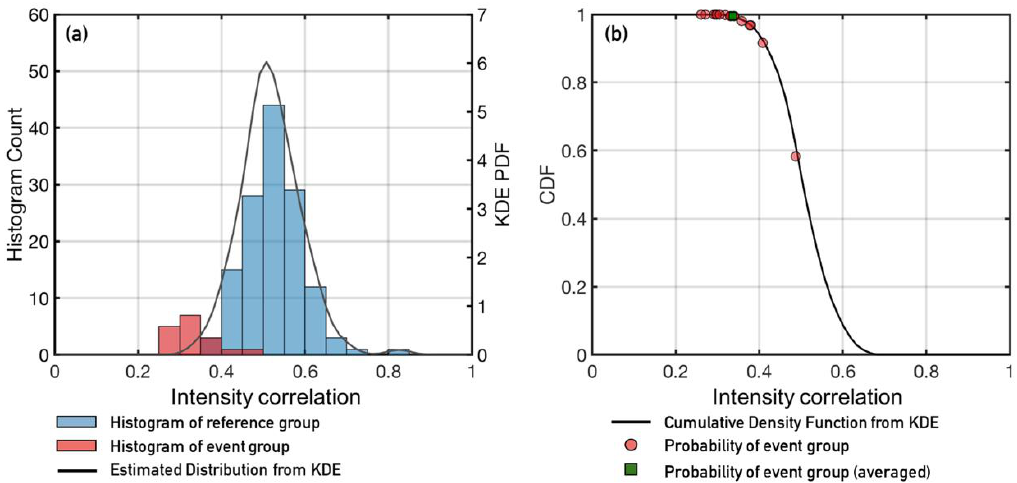
Figure 4. ( a ) Intensity correlation histograms for reference and event groups. The black line is the estimated distribution for the reference group using the Kernel Desity Estimation (KDE) method. ( b ) The cumulative density function (CDF) is calculated from the estimated distribution and probability of event (red circles and green square).